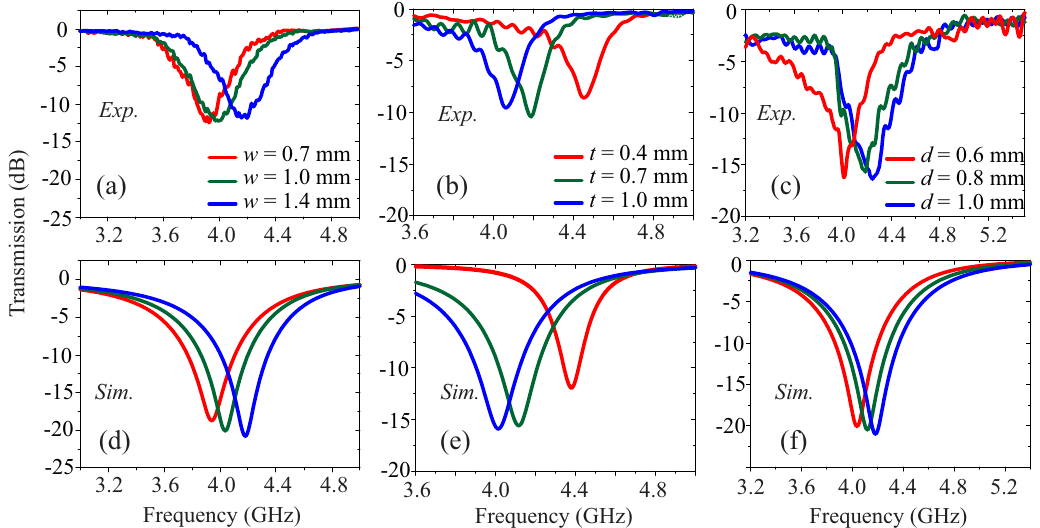
Figure A2. ( a , d ) Transmission spectra for PLA/Ag epoxy coated SRRs with various widths. Experimental data ( a ) in comparison with numerical simulations ( d ). ( b , e ) Corresponding transmission spectra for SRRs with different wire thickness. Experimental data ( b ) in comparison with numerical simulations ( e ). ( c , f ) Transmission spectra for SRRs with various gaps. Experimental data ( c ) in comparison with numerical simulations ( f ). The side length is equal to L = 10